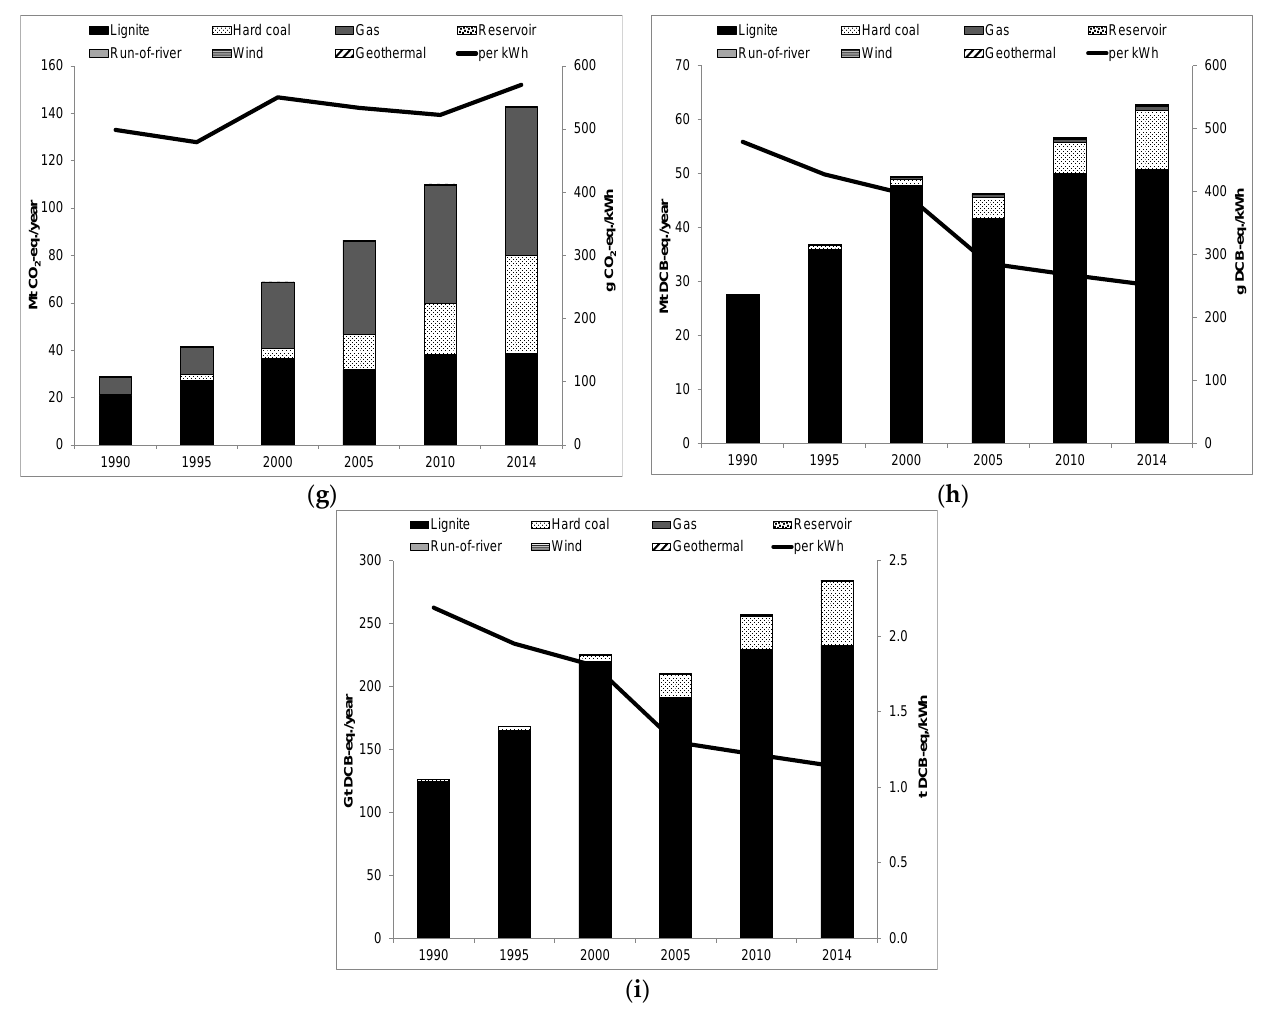
Figure 9. Cont. Figure 9.